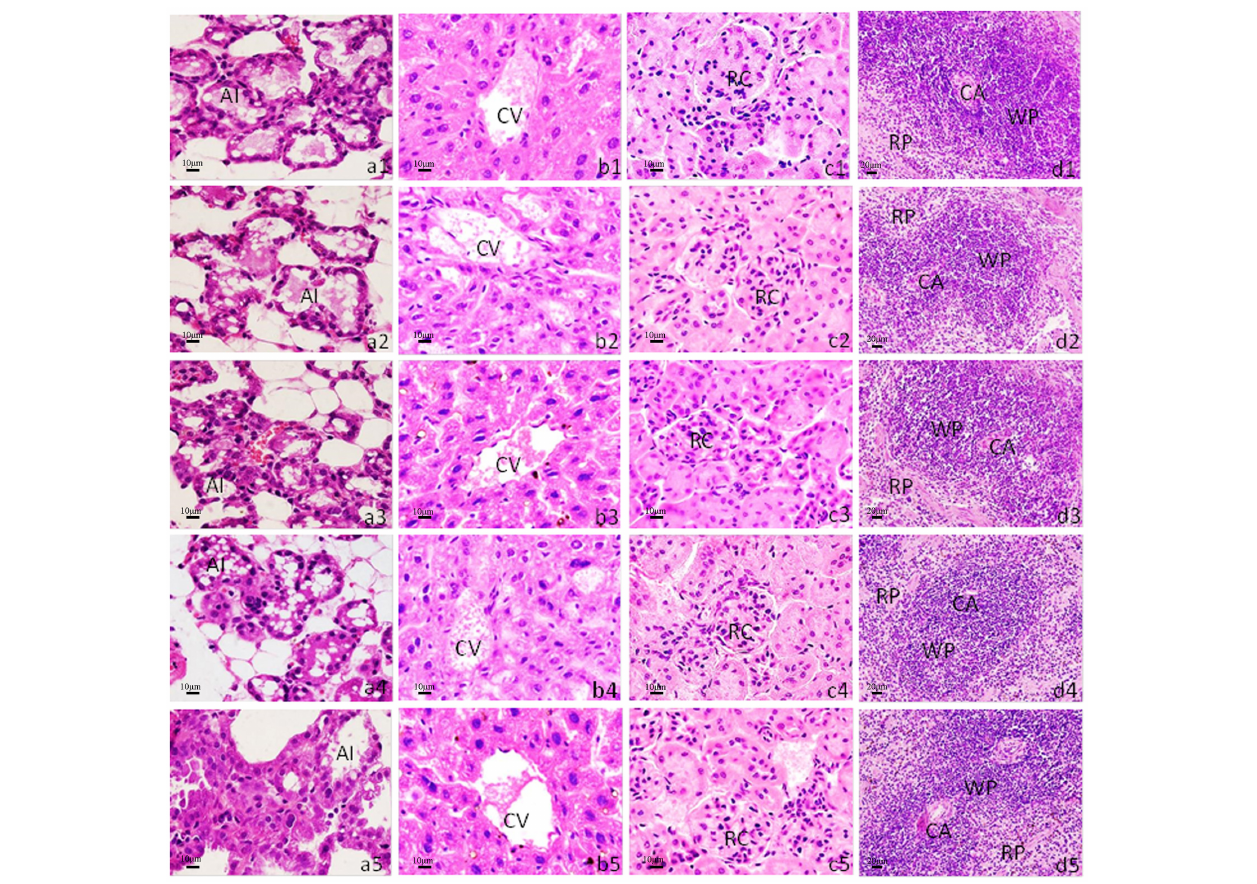
FIGURE 4 | Histological analysis of mouse mammary gland, liver, kidney, and spleen. H&E staining. The scale bar indicated as 10 µ m for mammary gland, liver, kidney, and 20 µ m for spleen. (a1–a5) Histological sections of mice mammary gland; (b1–b5) liver; (c1–c5) kidney; (d1–d5) spleen. (a1–d1) The tissues from control group which were inoculated the 80 µ g PBS; (a2–d2) inoculated the 60 µ g rwaaF; (a3–d3) inoculated the 80 µ g rwaaF; (a4–d4) inoculated the 60 µ g pcwaaF; (a5–d5) inoculated the 80 µ g pcwaaF. AI, acinus; CA, central artery; CV, central vein; RC, renal corpuscle; RP, red pulp; WP, white